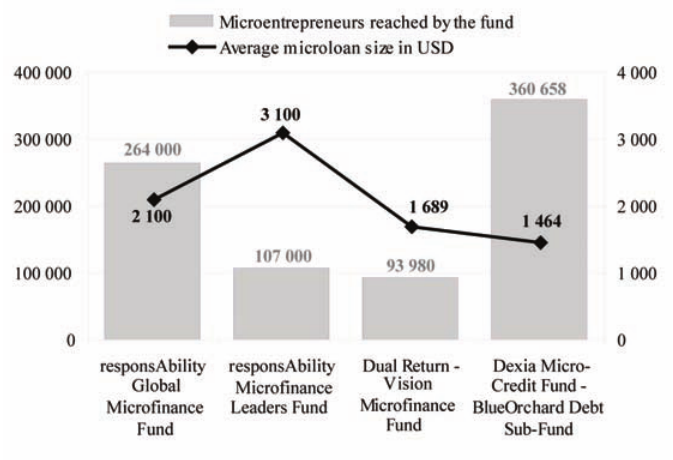
Fig. 2. Microlenders Reached by Funds and Average Microloan Size